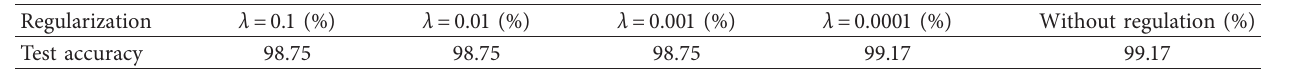
Table 6: Comparison of test results under different regularization parameters.